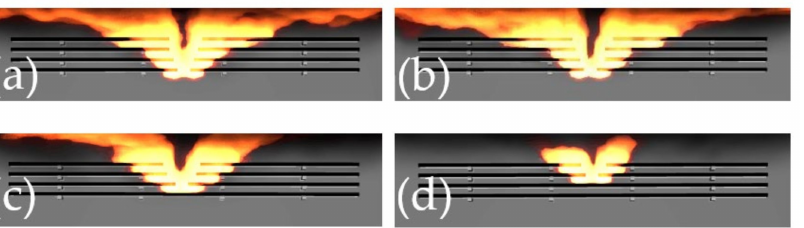
Figure 14. Flame propagation for different ignition positions: ( a ) D1 700 s; ( b ) D2 700 s; ( c ) D3 700 s; ( d ) D4 700 s.